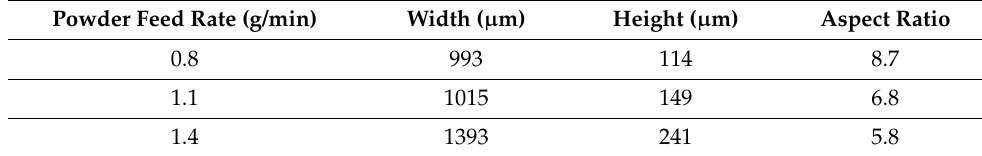
Table 11. Width, height, and aspect ratio for each of the experimental conditions.